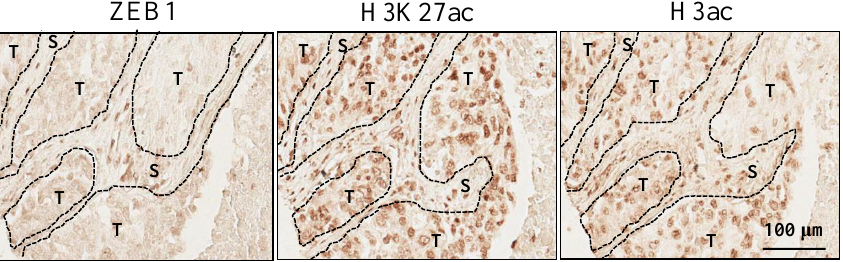
Figure 9. Staining for ZEB1, H3K27 acetylation, and H3 acetylation on a TMA. One example of a lung squamous adenocarcinoma is shown. T and S indicate tumor and stroma compartments